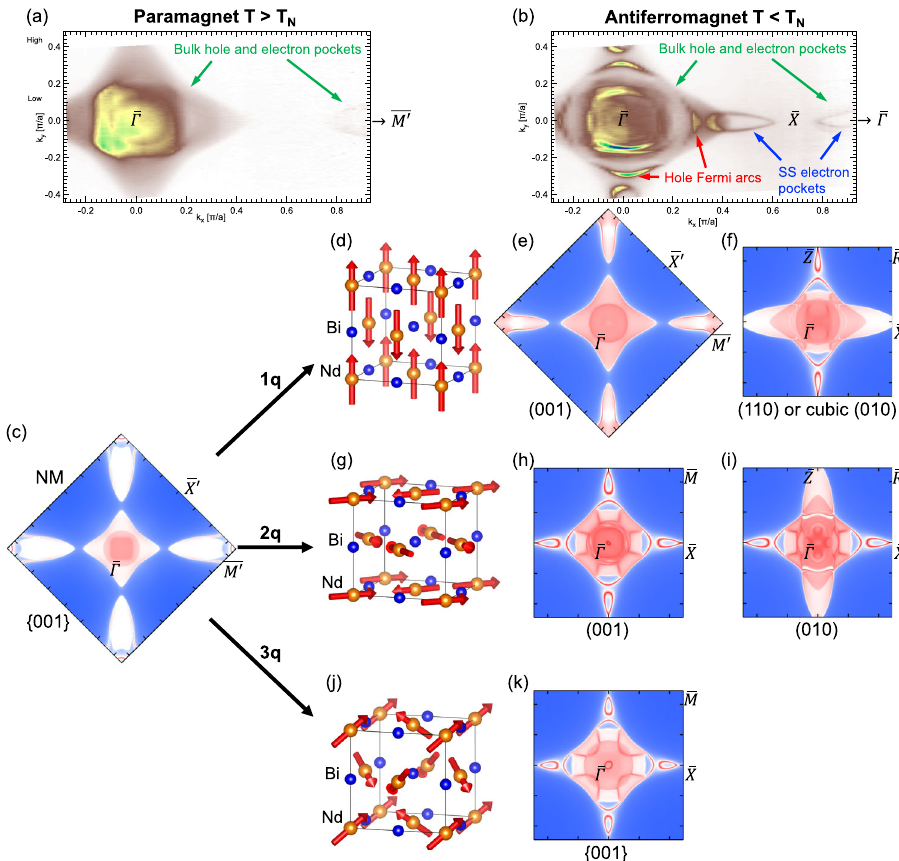
Fig. 1 2D surface Fermi surface (SFS) of NdBi. Angle-resolved photo-electron spectroscopy (ARPES) at ( a ) T > T N and ( b ) T < T N with the unconventional surface state (SS) of hole Fermi arcs and SS electron pockets. The calculated SFS on (001) for ( c ) non-magnetic (NM) and anti-ferromagnetic (AFM) with ( d – f ) 1q, ( g – i ) 2q and ( j , k ) 3q wave vectors on different surfaces as labeled. The multi-q magnetic structures are shown in ( d ), ( g ), and ( j ). The orange (blue) spheres stand for Nd (Bi) atoms and the red arrows show the directions of Nd magnetic moments. The surface Brillouin zone for NM and 1q (001) is twice as large and rotated by 45 degree with respect to that for 2q and 3q (see Fig. 2b) for labels of high symmetry points). The 1q tetragonal (110) vertical diagonal surface in ( f ) is equivalent to the cubic (010) side surface. Blue, white and red colors stand for low, medium, and high density of